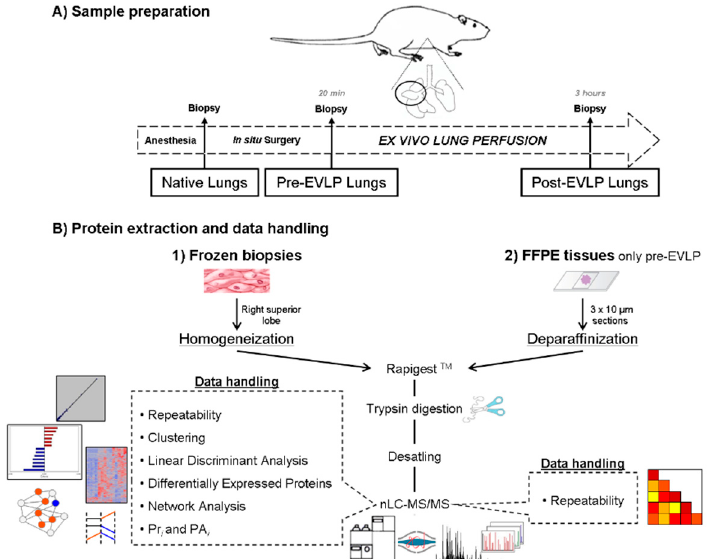
Figure 1. Experimental pipeline. Applied workflow for proteomic investigation of frozen and